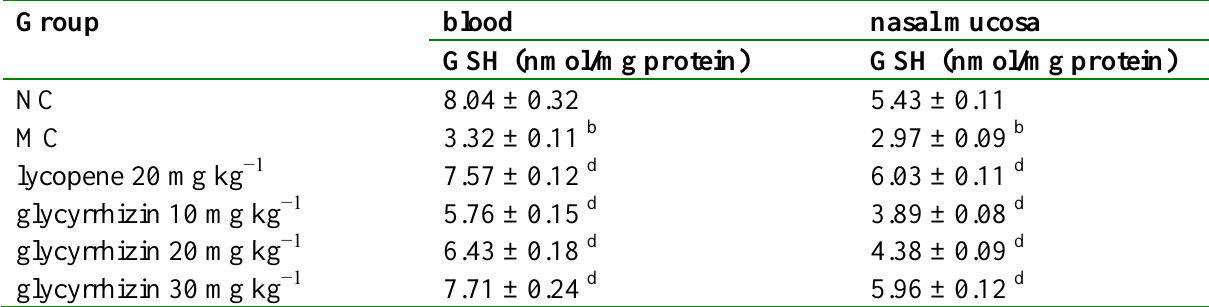
Table 4. Blood and nasal mucosa GSH levels in different